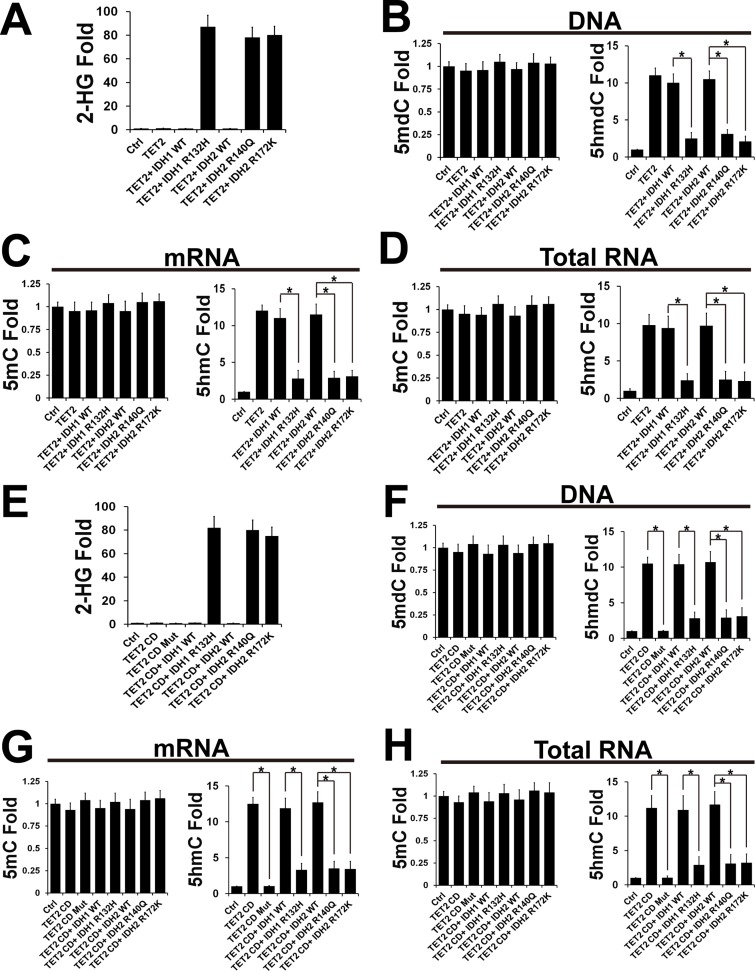
IDH1/2 mutants inhibit TET-promoted oxidation of RNA 5mC to 5hmC.(A) HEK293 cells were transfected with/without pS-Flag-SBP (control), pS-Flag-SBP TET2, IDH1 WT, IDH1 (R132H), IDH2 WT, IDH2 (R140Q) and/or IDH2 (R172K) as noted. After 48 hrs, 2-HG was extracted and analyzed by mass spectrometry. The cells transfected with pS-Flag-SBP were taken as control (Ctrl). (B) LC-MS/MS analysis of the DNA from (A). (C) LC-MS/MS analysis of the mRNA from (A). (D) LC-MS/MS analysis of the total RNA from (A). (E)HEK293 cells were transfected with/without pCDNA3, pCDNA3B-Flag-TET2 CD, pCDNA3B-Flag-TET2 CD mut, IDH1 WT, IDH1 (R132H), IDH2 WT, IDH2 (R140Q) and/or IDH2 (R172K) as noted. After 48 hrs, 2-HG was extracted and analyzed by mass spectrometry. The cells transfected with pCDNA3 were taken as control (Ctrl). (F) LC-MS/MS analysis of the DNA from (E). (G) LC-MS/MS analysis of the mRNA from (E). (H) LC-MS/MS analysis of the total RNA from (E).